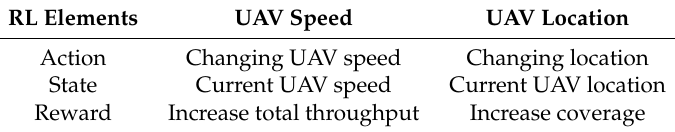
Table 1. Basic reinforcement learning elements in